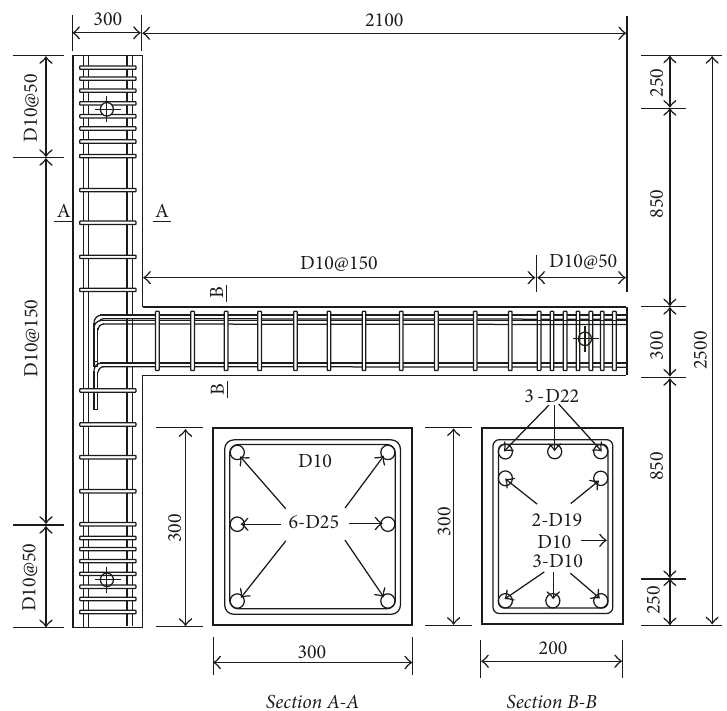
Figure 2: Configurations and details of control specimen.